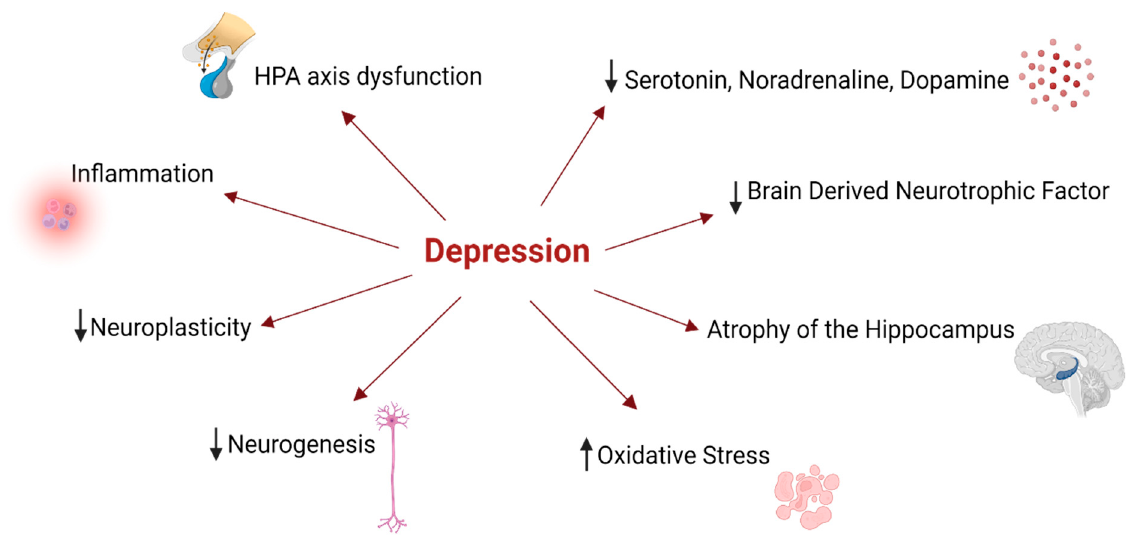
Figure 2. Depression is a complex disease. Hypothalamic–pituitary–adrenal (HPA) axis dysfunction, low levels of neurotransmitters (such as 5-HT, noradrenaline, and dopamine) and neurotrophic factors (such as BDNF), brain atrophy of regions such as the hippocampus, increased levels of inflammation and oxidative stress, and decreased levels of neurogenesis are some underlying features of depression. Illustration created with BioRender [8].